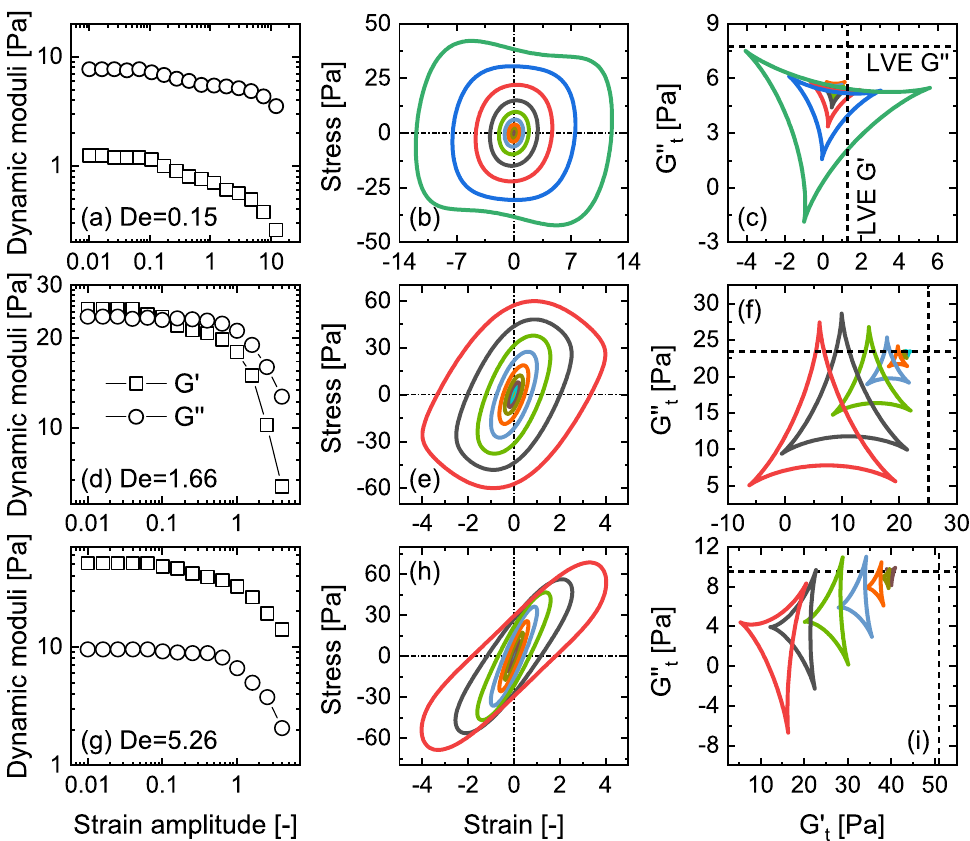
Figure A1. Amplitude dependence of oscillatory shear responses. ( a , d , g ) Dynamic moduli ( G (cid:48) , G (cid:48)(cid:48) ) as a function of applied strain amplitude. ( b , e , h ) stress versus strain across the amplitudes. ( c , f , i ) time-dependent viscous modulus versus time-dependent elastic modulus ( G (cid:48)(cid:48) t − G (cid:48) t ) across the